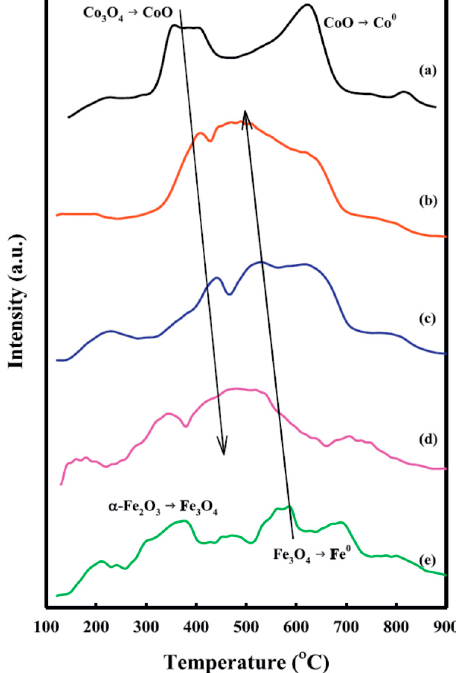
Figure 17. H 2 -TPR profiles of monometallic and bimetallic catalysts supported on γ -alumina: (a) 20Co/ γ -Al 2 O 3 , (b) 15Co–5Fe/ γ -Al 2 O 3 , (c) 10Co–10Fe/ γ -Al 2 O 3 , (d) 5Co–15Fe/ γ -Al 2 O 3 , and (e) 20Fe/ γ -